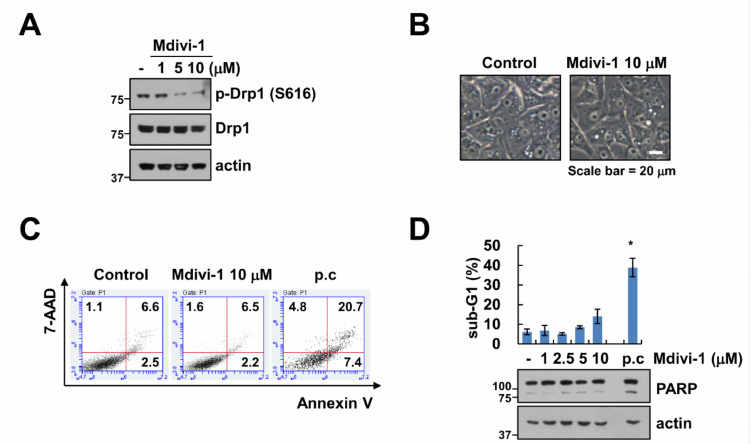
Figure 1. E ff ect of mdivi-1 on apoptosis in human renal carcinoma cell line Caki-1. ( A – D ) Caki-1 cells were treated with 1–10 µ M mdivi-1 for 24 h. The cell morphology ( B ) and cell death ( C ) were examined using interference light microscopy and Annexin V / 7-AAD staining, respectively. The sub-G1 population and protein expression were detected by flow cytometry ( D ) and Western blotting ( A , D ) respectively. Positive control (p.c); TNF- α plus CHX. The values in graph ( D ) represent the mean ± SEM of three independent experiments. * p < 0.01 compared to the